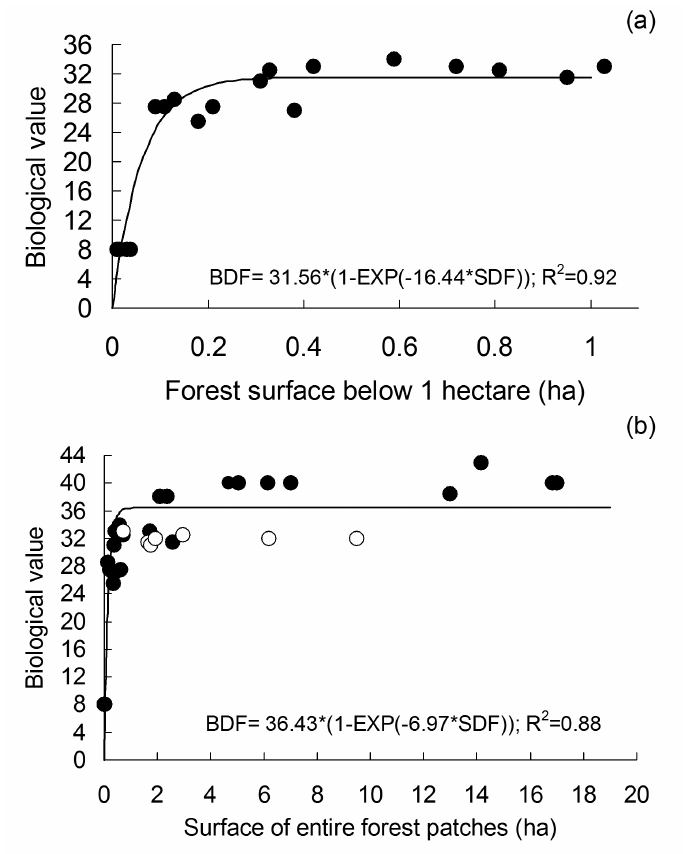
Figure 4. Frequency distribution of degraded deciduous forest patches in relation to surface. Asymptotic relationship between index of biological value for degraded deciduous forest (BDF = unitless) and patch size (SDF = ha) at catchment scale (n=29). Asymptotic equations obtained by non-linear regression analyses are